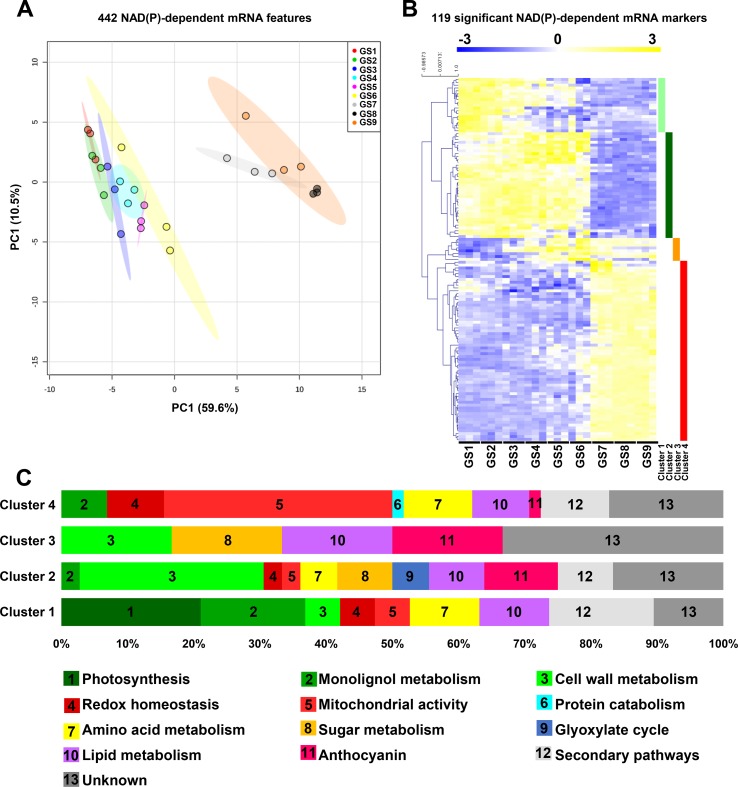
Expression of genes for NAD(P)-dependent enzymes reveals distinct clusters during tomato fruit growth. Normalized transcript data of 442 transcript features of NAD(P)-dependent enzyme (see Materials and Methods) were visualized (A) for global impact of the growth stage of tomato fruit by PCA (with maximal variation given into brackets). Same features were then filtered (ANOVA with Bonferroni correction, P < 0.01) and subjected to clustering analysis (B) using MeV (http://mev.tm4.org/). Shown are Pearson’s correlations after complete clustering of 119 significant mRNA profiles. Four clusters were identified and analyzed for functional classification based on their gene ontology annotations (C). GS, growth stage.